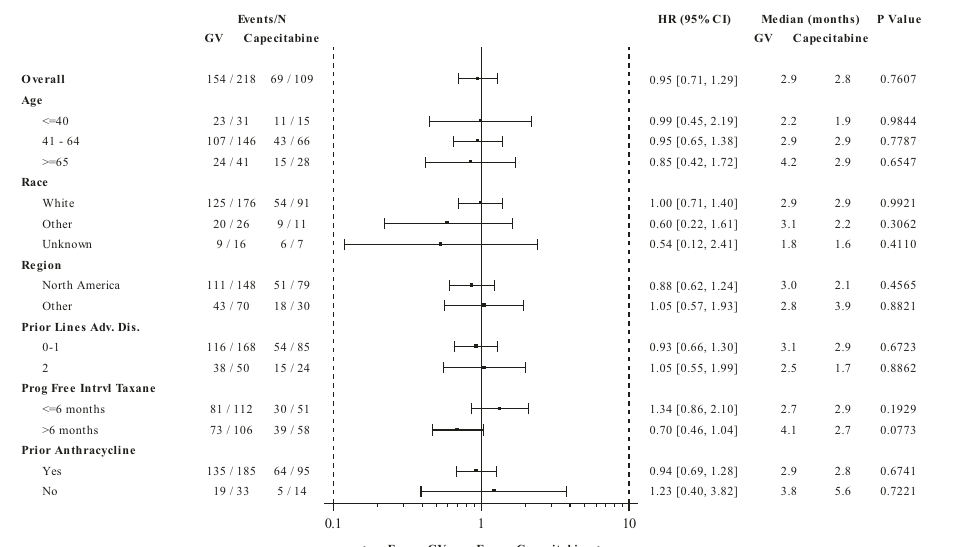
Fig. 4 Progression-free survival by demographics and strati fi cation factors. Progression-free survival was determined in the intention-to- treat population, based on Independent Review Committee assessments. A forest plot for progression-free survival for GV compared with capecitabine is shown by demographics and by study pre-speci fi ed randomization factors: number of prior lines of cytotoxic chemotherapy for advanced disease, progression-free interval post last receipt of taxane, and prior receipt of anthracycline. The black square represents the hazard ratio, whereas the odds ratios (95% CIs) are denoted by black lines.